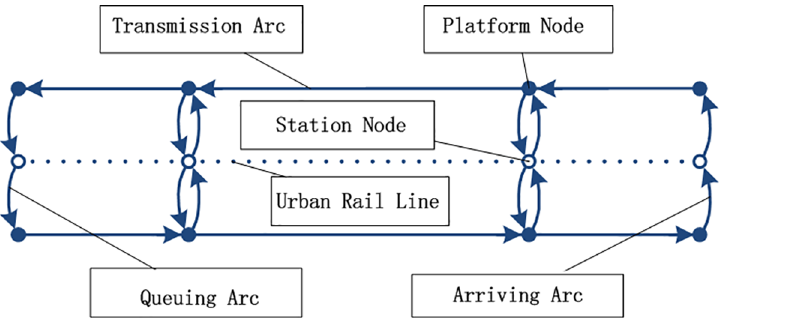
Fig 1. Illustration of the urban rail network with a single line.